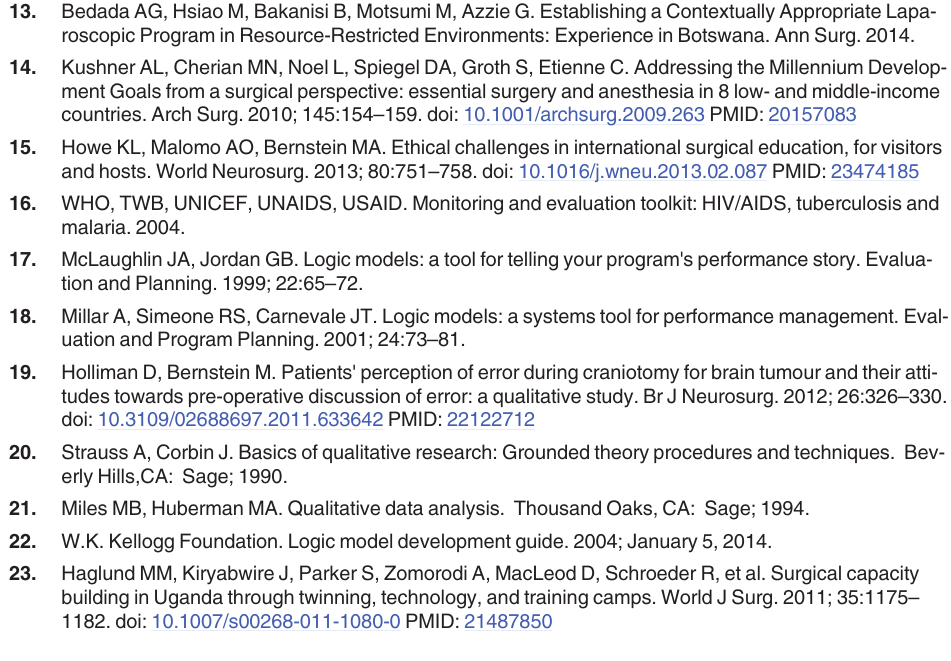
PLOS ONE | DOI:10.1371/journal.pone.0120368 March 30,